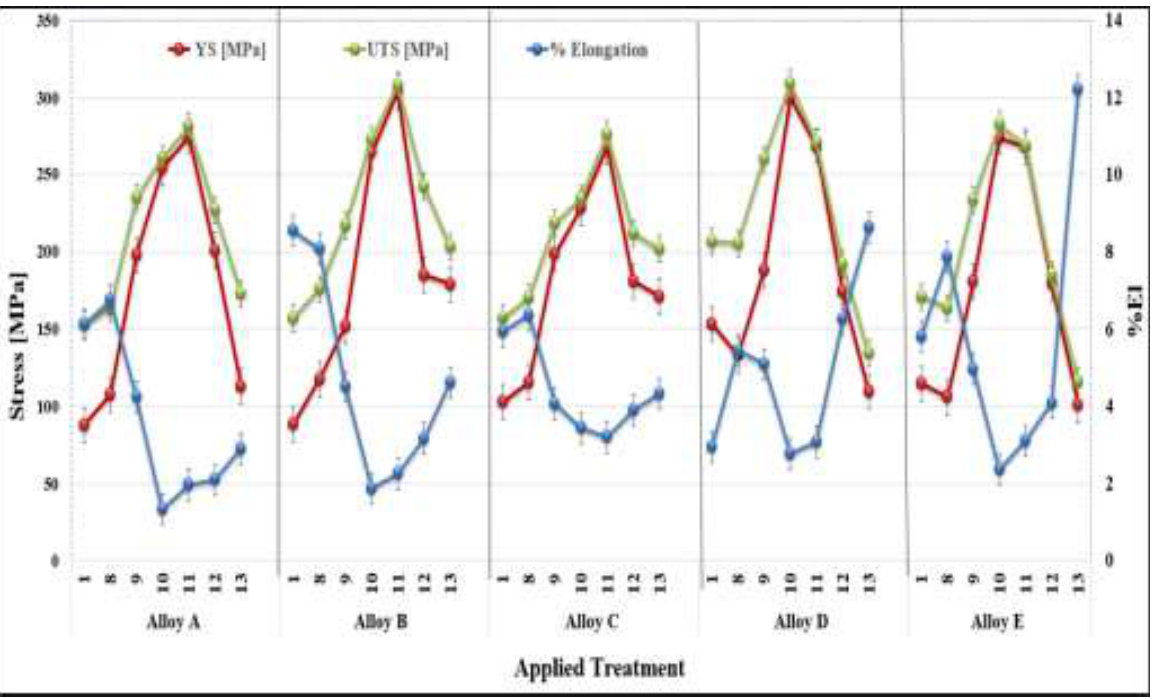
Figure 10. Variation in the tensile properties of the alloys tested at 250 ° C as a function of the alloy composition and the applied heat treatment.